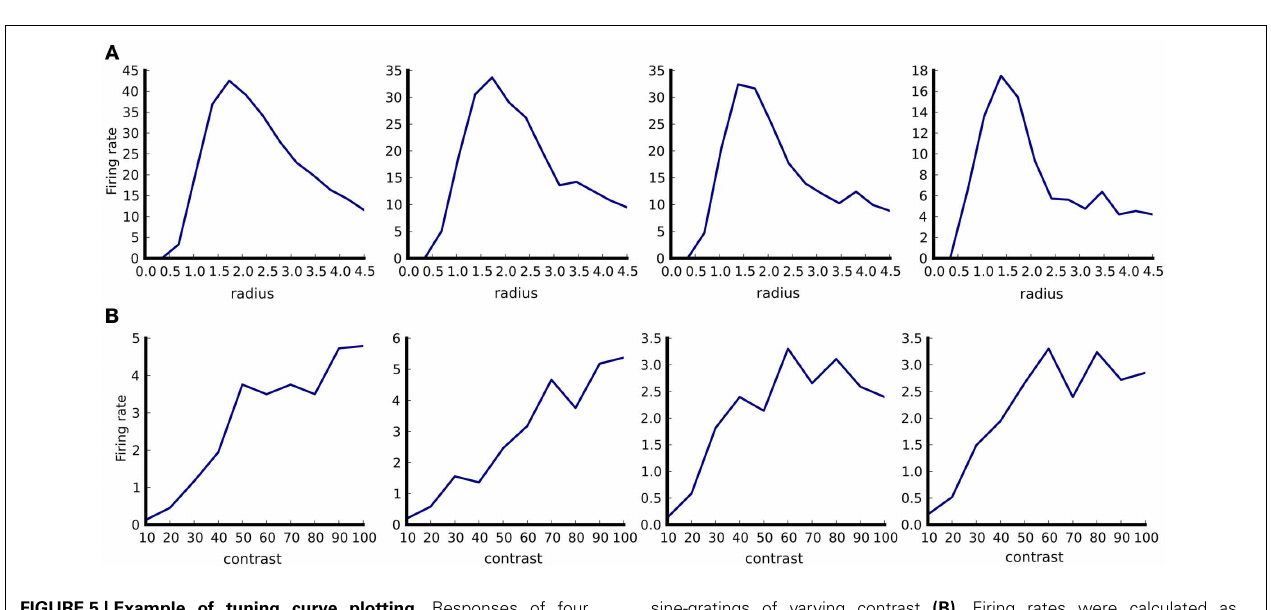
sine-gratings of varying contrast (B) . Firing rates were calculated as spike counts during the one second stimulus presentation and averaged over ten trials. The aperture diameter is in degrees of visual